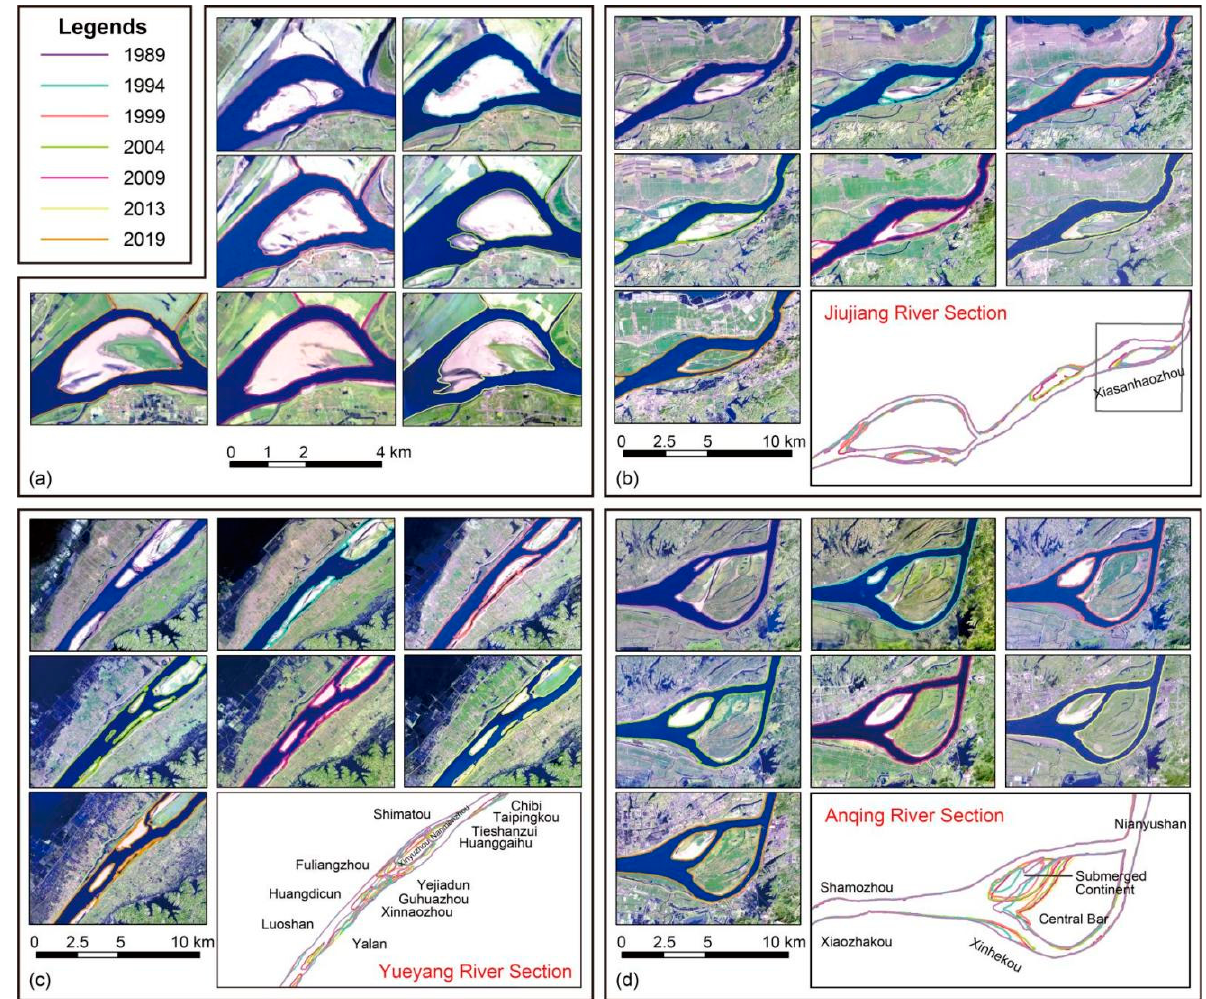
Figure 5. River channel changes in different periods of the river sections. ( a ): Evolution of planar morphology in Xinzhou from 1989 to 2019; ( b ): Jiujiang River section; ( c ): Yueyang River section; ( d ): Anqing River section.